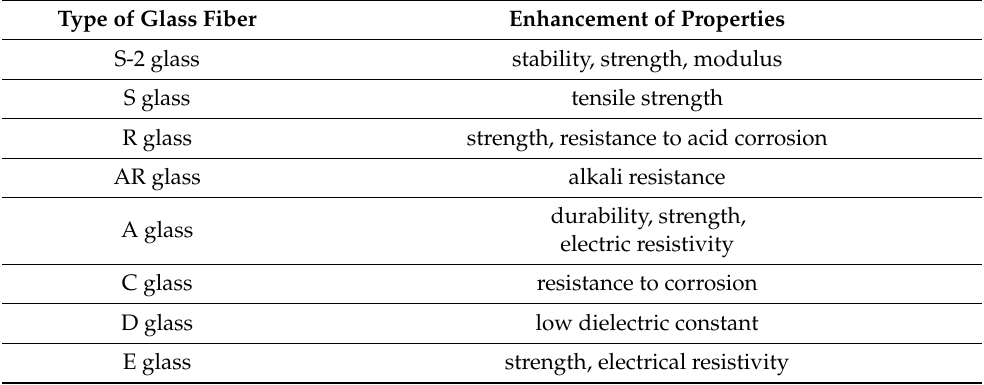
Table 1. Types of glass fiber reinforcement and their influence on physical properties